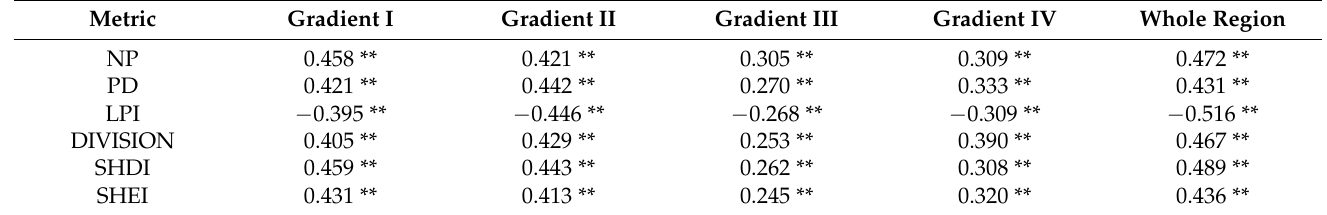
Table 9. Correlation coefficients between habitat quality variation and landscape metrics variations from 2005 to 2020.